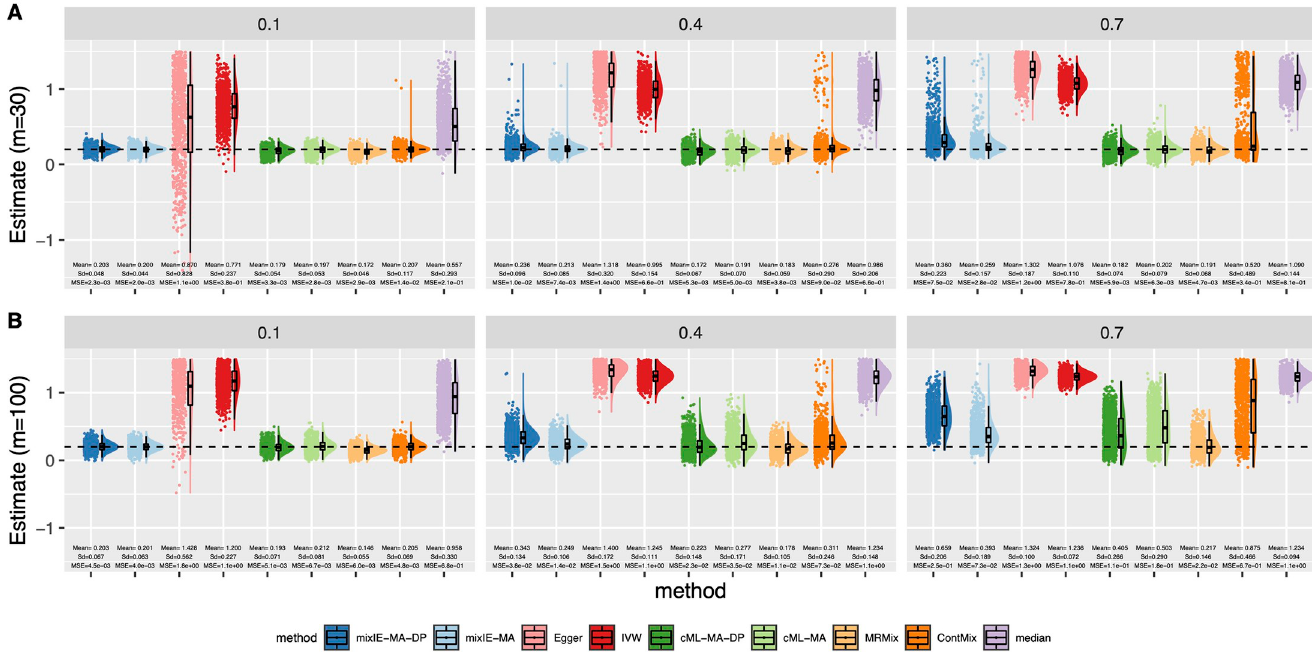
Fig 7. Simulation results with directional pleiotropy and InSIDE violated. Empirical distributions of the estimates of the causal effect θ by the methods with n = 50 000, θ = 0.2 and 70% invalid IVs. A: m = 30. B: m = 100. Each column corresponds to b = 0.1, 0.4, 0.7.